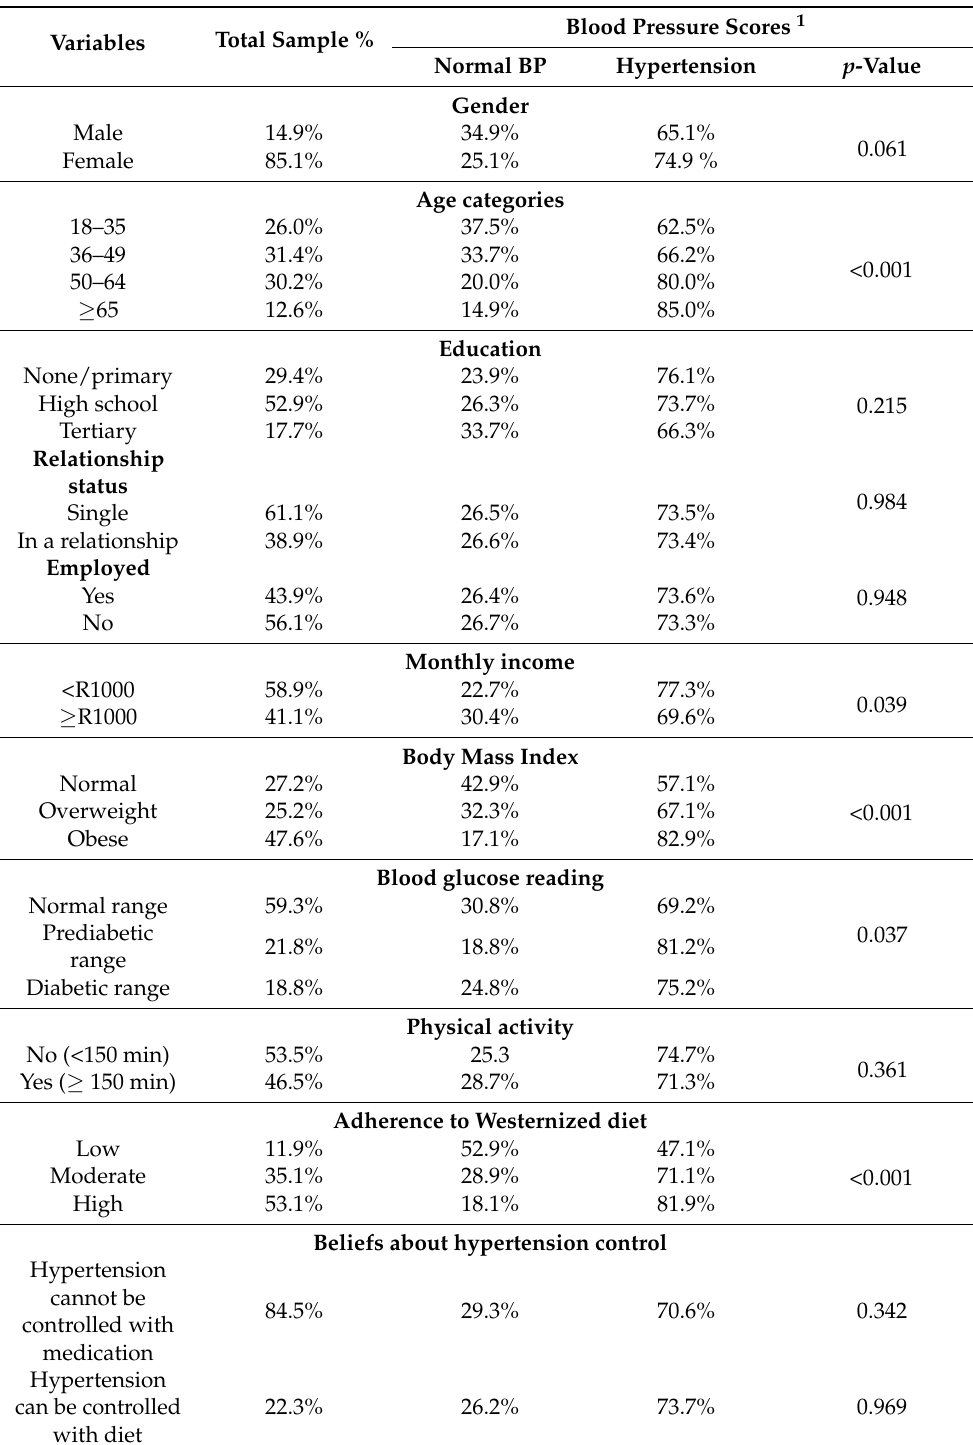
Table 1. Sociodemographic and clinical characteristics of the population along with the status of their blood